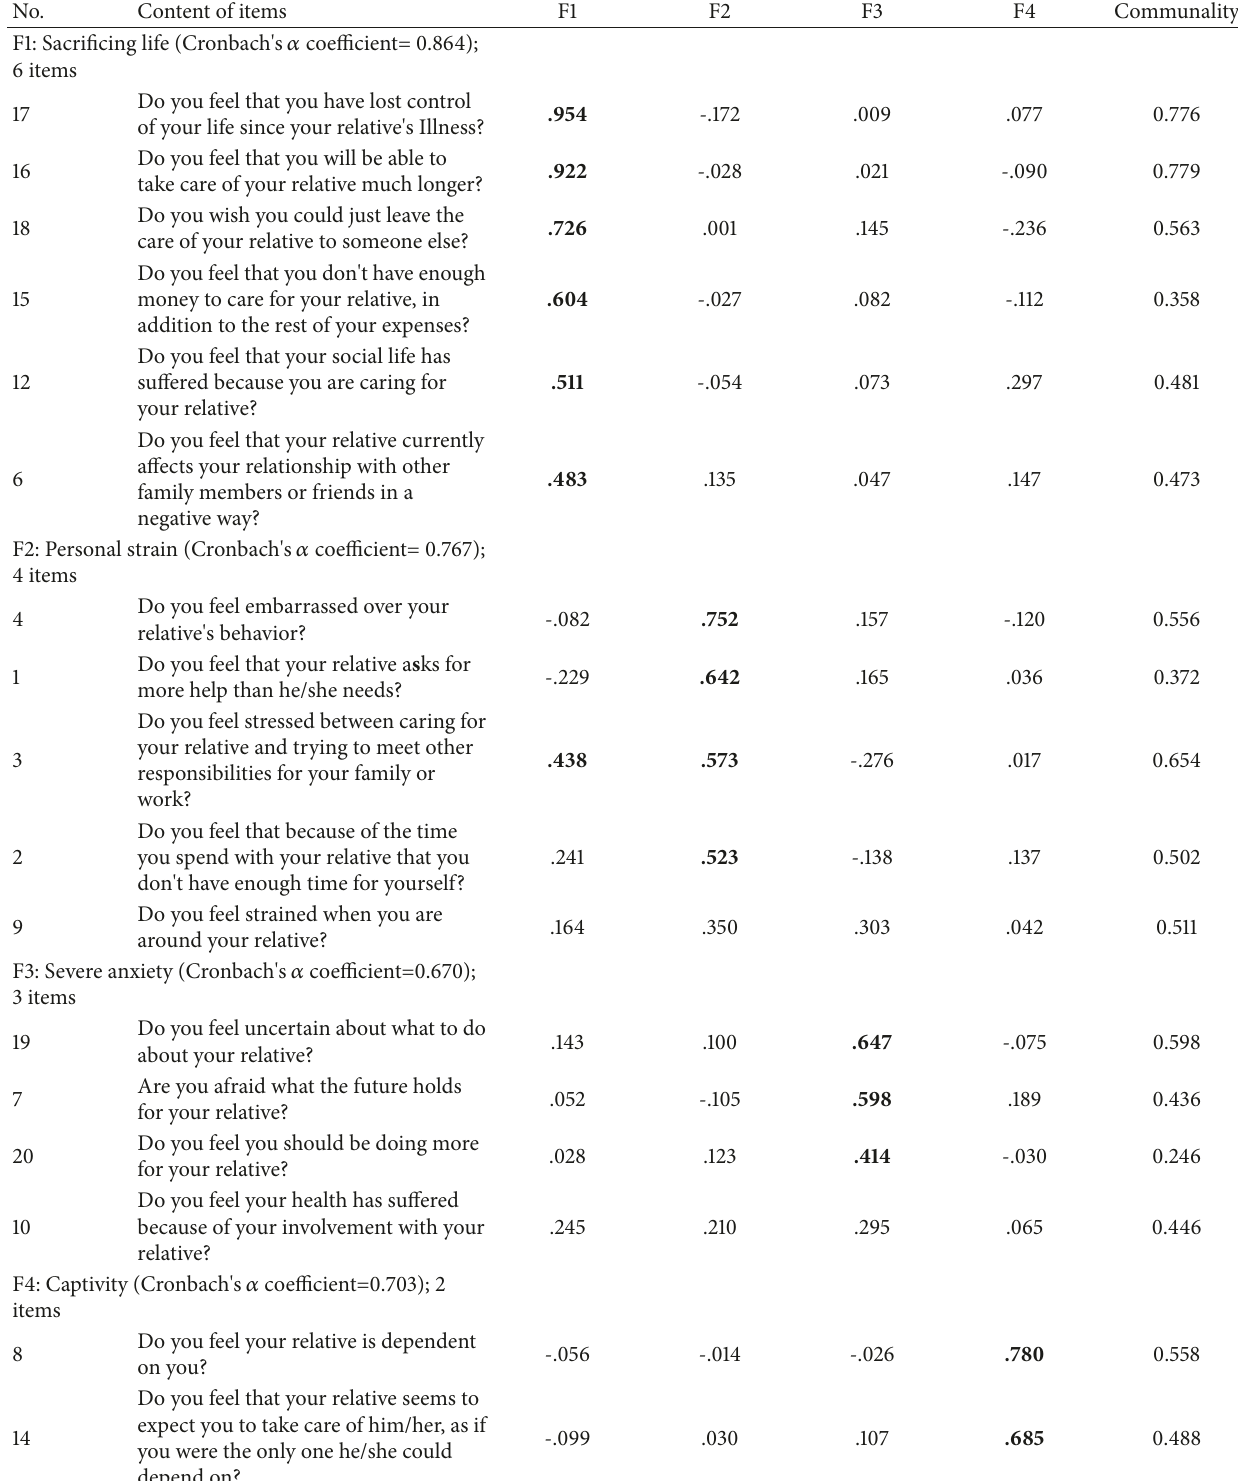
Table 3: Four-factor structure in the present